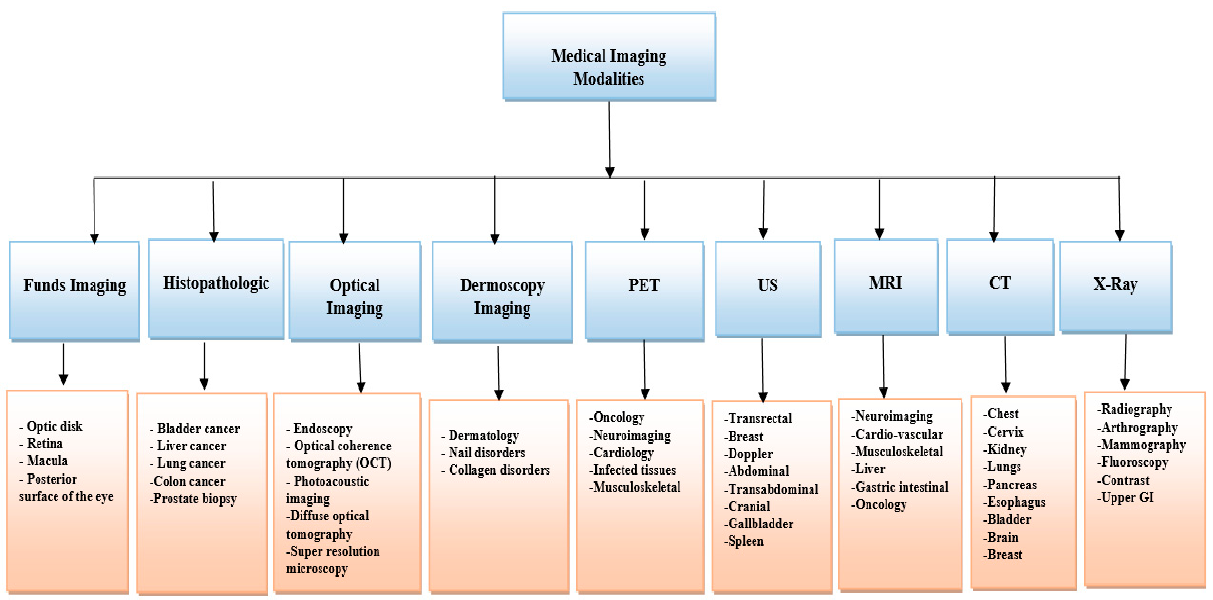
Figure 2. Classification of medical imaging modalities.